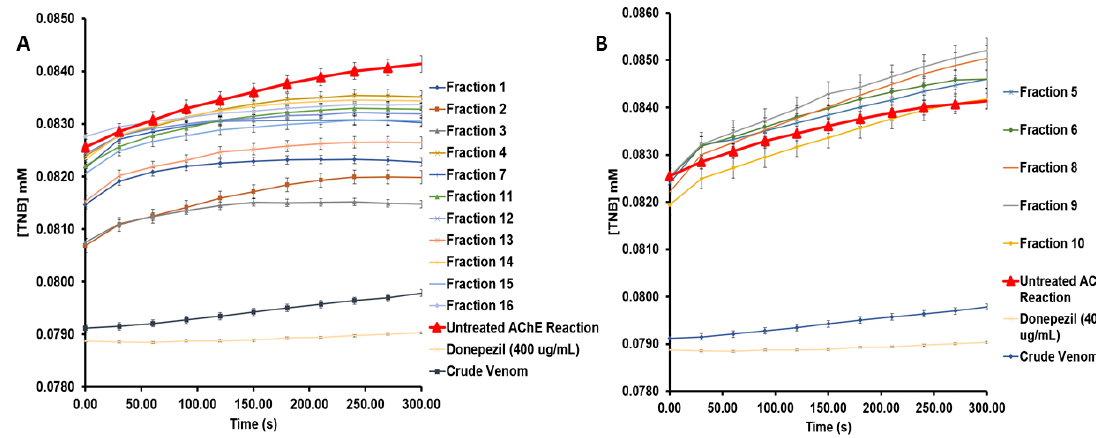
Figure 7. Time-dependent AChE kinetic analysis of (A) anti-AChE and (B) pro-AChE of venom fractions alongside with whole venom, Donepezil, and untreated AChE reaction. Data are reported as mean ± SEM (bars) (n =